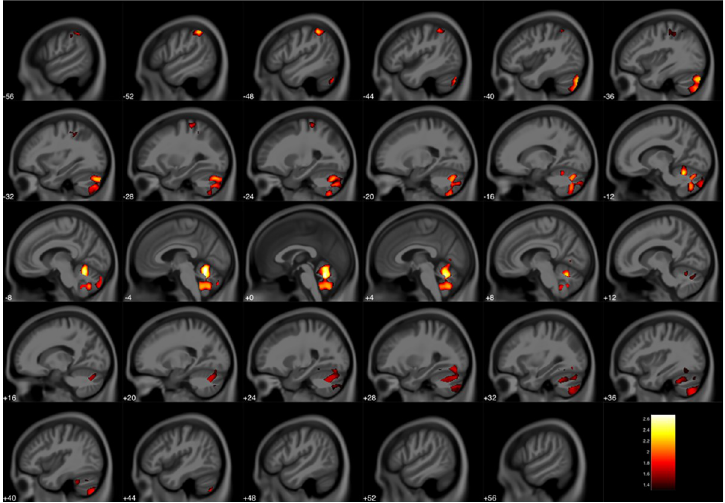
Fig 2. Reduced gray matter volume in the high ECAT group compared to the low ECAT group. Clusters were corrected for multiple comparisons using threshold free cluster enhancement with a familywise error rate of p � 0.05. Color bar represents–log(p)